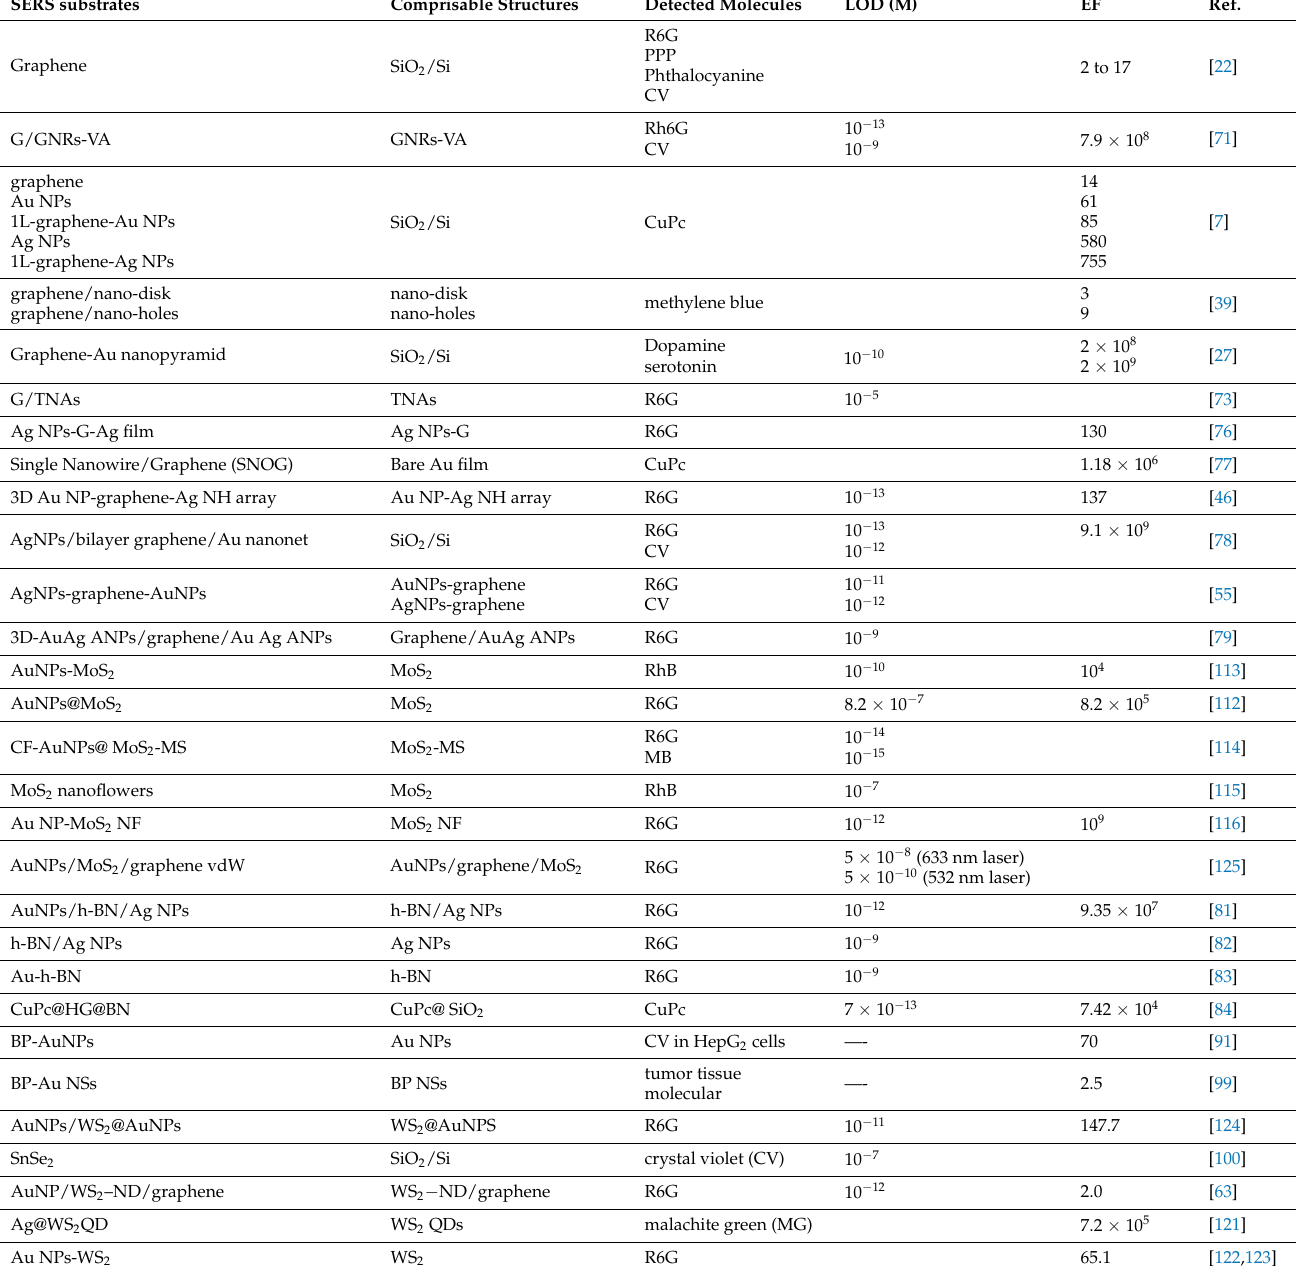
Table 1. The collected EF and LOD of the SERS system combing with different 2D